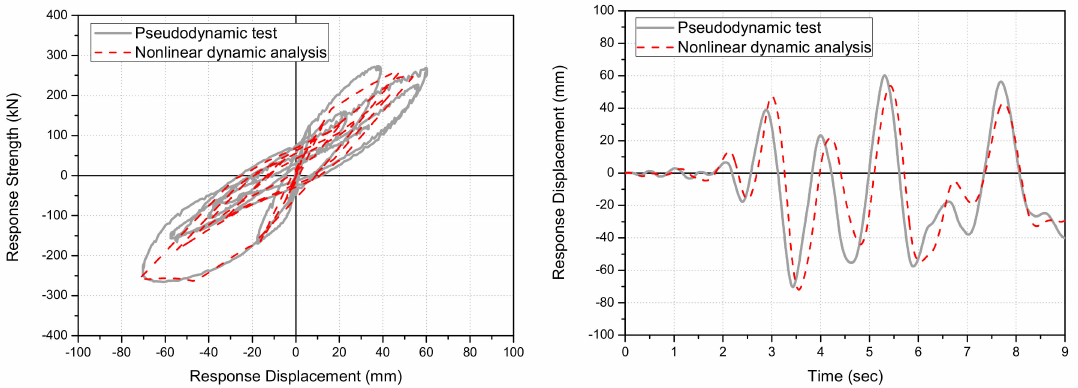
Figure 24. Comparison of seismic response load-displacement and displacement hysteresis loops during nonlinear dynamic analysis and pseudo-dynamic tests of the test frame with no reinforcement applied (first floor, 200 cm/s 2 ).